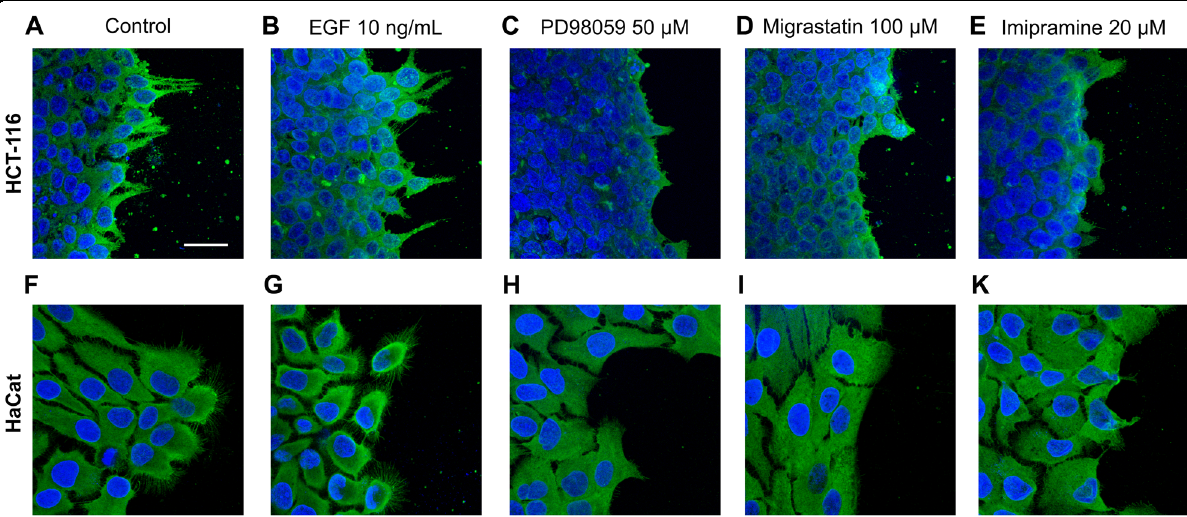
Fig. 5 Cell morphology of HCT-116 and HaCat cells upon inhibition of lamellipodia and fi lopodia formation. Inset shows the immuno fl uorescence analysis of the fascin1 marker (green) under control conditions: a – f control conditions, b – g 10 ng/mL EGF (migration stimulator), c – h 50 µM PD98059 (MEK inhibitor), d – i 100 µM migrastatin, and e – k 20 µM imipramine. Images were captured using an LSM 510 META confocal fl uorescence microscope with a ×63 oil objective. Scale bar 30 µm. Migrastatin and imipramine inhibit lamellipodia protrusion and fascin1 localization in a similar way to the migration MEK inhibitor PD98059 in both cell lines.